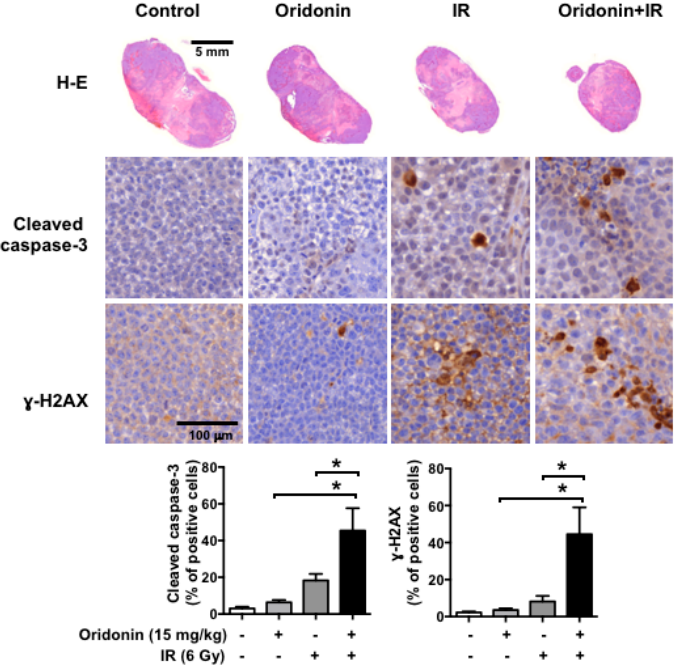
Figure 7. Histopathological analysis of H460 tumors following combination treatment with oridonin and radiation. Hematoxylin and eosin (H-E) staining and immunohistochemistry for cleaved caspase-3 and γ -H2AX were performed on tumors harvested at 14 days after IR. Representative images of H-E-stained tumors ( upper images ) and cleaved caspase-3- and γ -H2AX-positive cells ( middle images , brown staining) and quantification of cleaved caspase-3 and γ -H2AX-positive staining with six mice in each group ( lower plots , means ± SEM) are shown; * p <